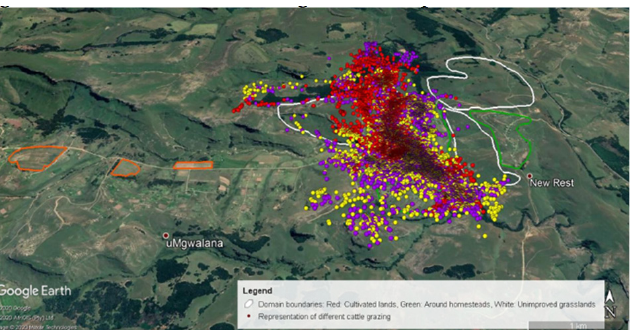
Figure 8. Google Earth plot showing the grazing distribution of three different cattle during the dry season.